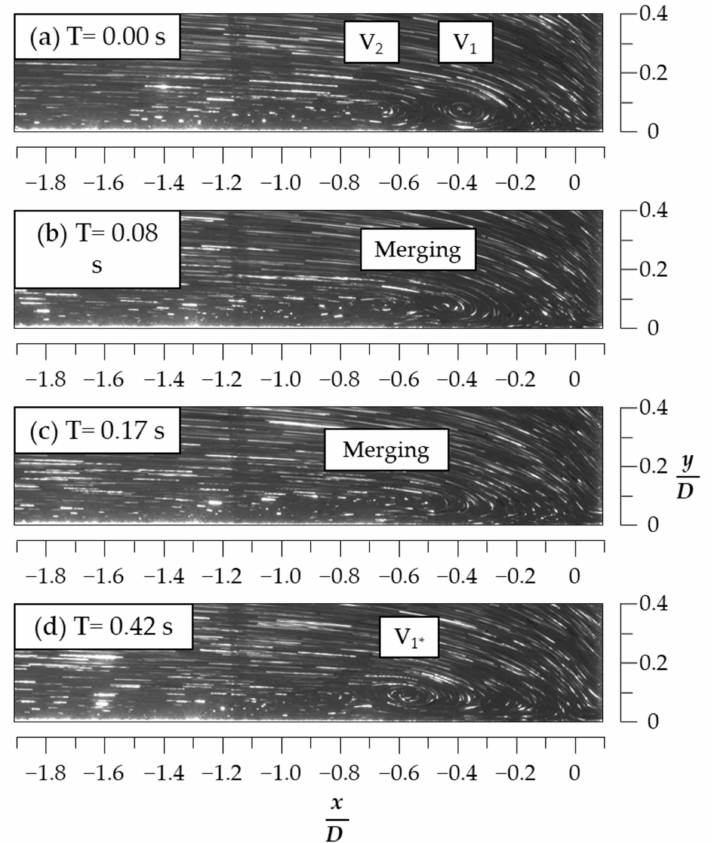
Figure 12. Time-series flow visualization of the HSV’s kinematic mode: “merging” in the z = 0.4 cm plane when H / D = 1.5. ( a ) The cores of two primary vortices V 1 and V 2 were initially located at ( x / D , y / D ) = ( − 0.37, 0.07) and ( − 0.66, 0.08), respectively; from ( b ) to ( c ), V 2 and V 1 were approach- ing and merging with each other; ( d ) a new primary vortex V 1* formed with its core located at ( x / D , y / D ) = ( − 0.57, 0.09).